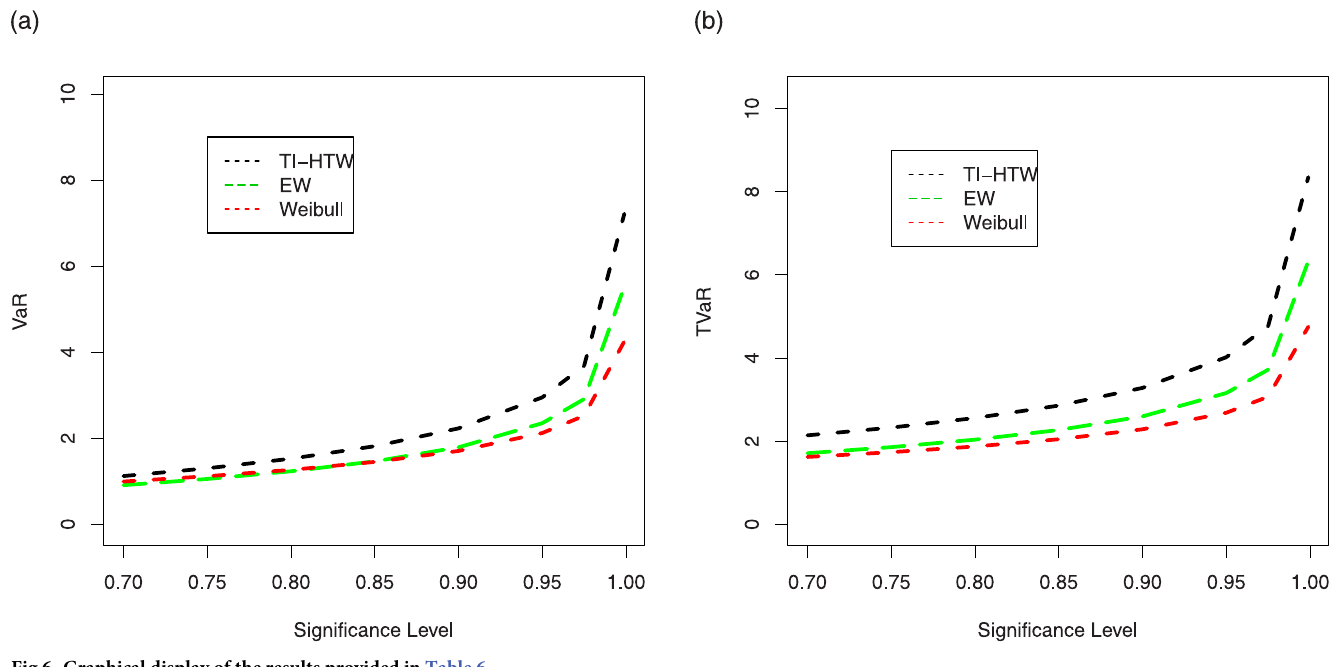
Fig 6. Graphical display of the results provided in Table